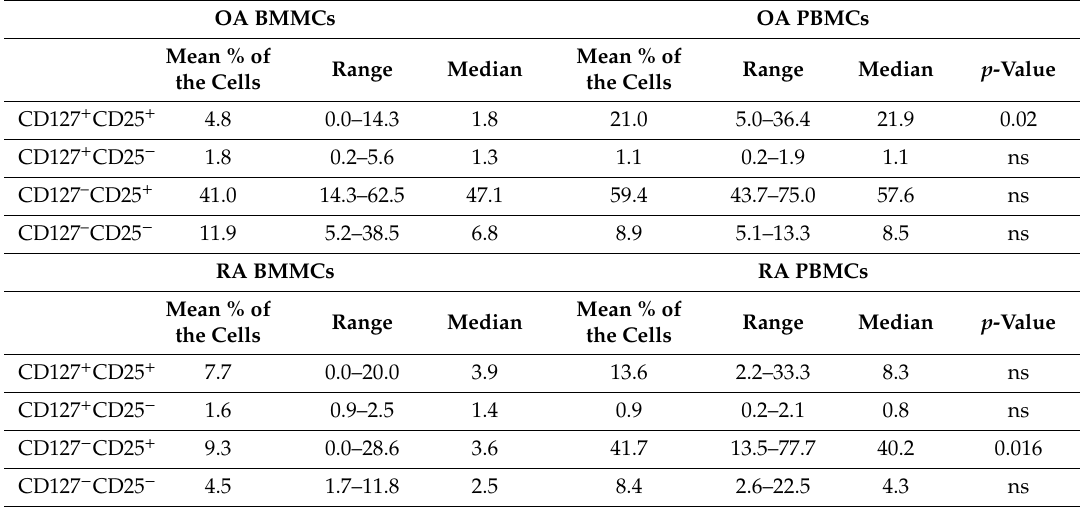
Table 2. Percentage of CD4 + FOXP3 + cells in CD4 + CD127 +/ − CD25 +/ − subsets in BM mononuclear cells (BMMCs) and peripheral blood mononuclear cells (PBMCs) isolated from OA and RA patients ( n = 6 in each group); ns—not